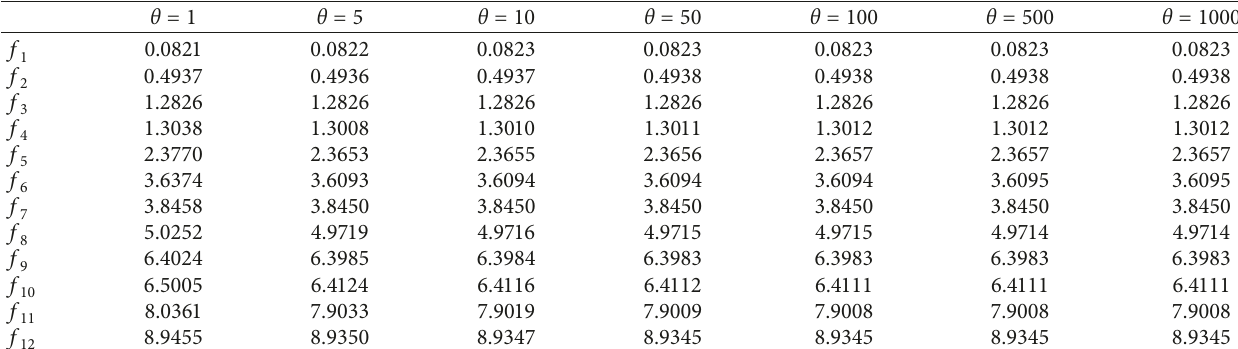
10 4 Hz) for different correlation parameters θ ×